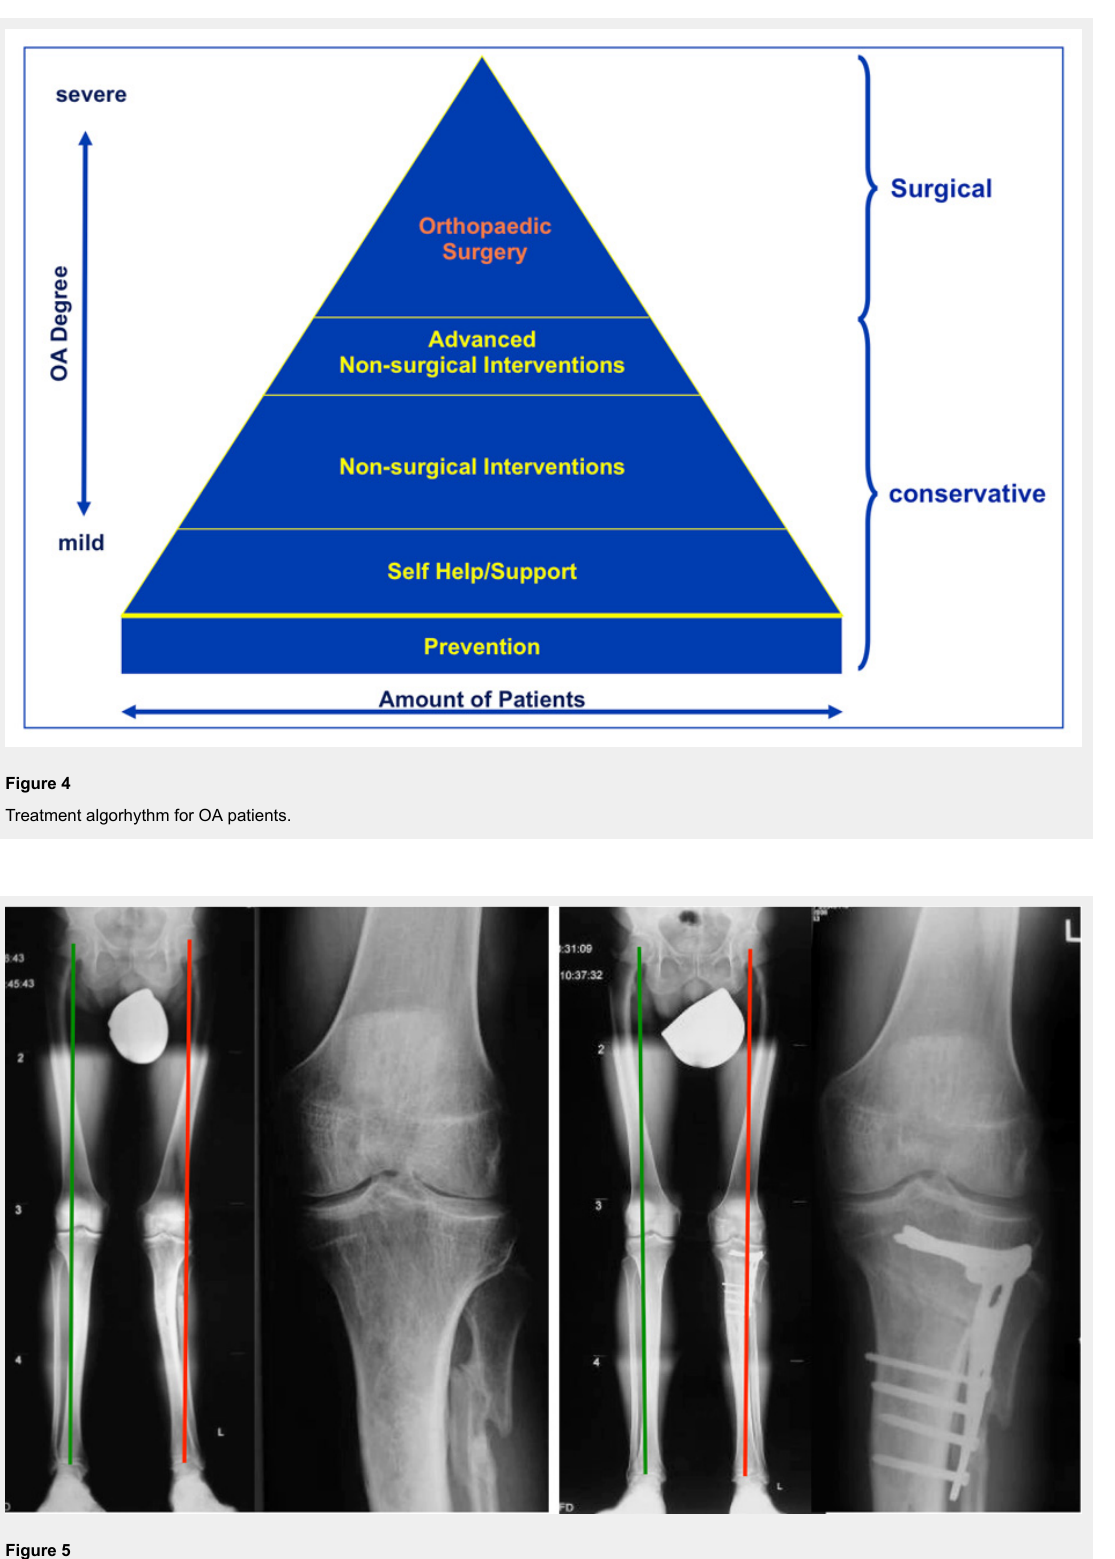
Figure 5 Patient before and after realignment surgery with an open wedge osteotomy of the proximal